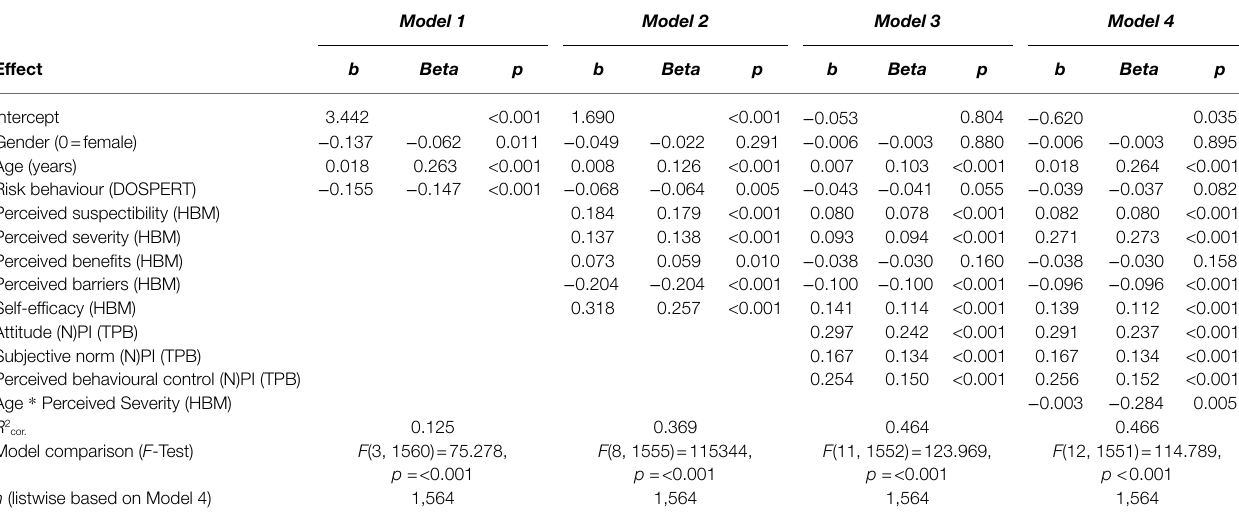
TABLE 6 | Modelling results (with bloc-wise comparison of different model